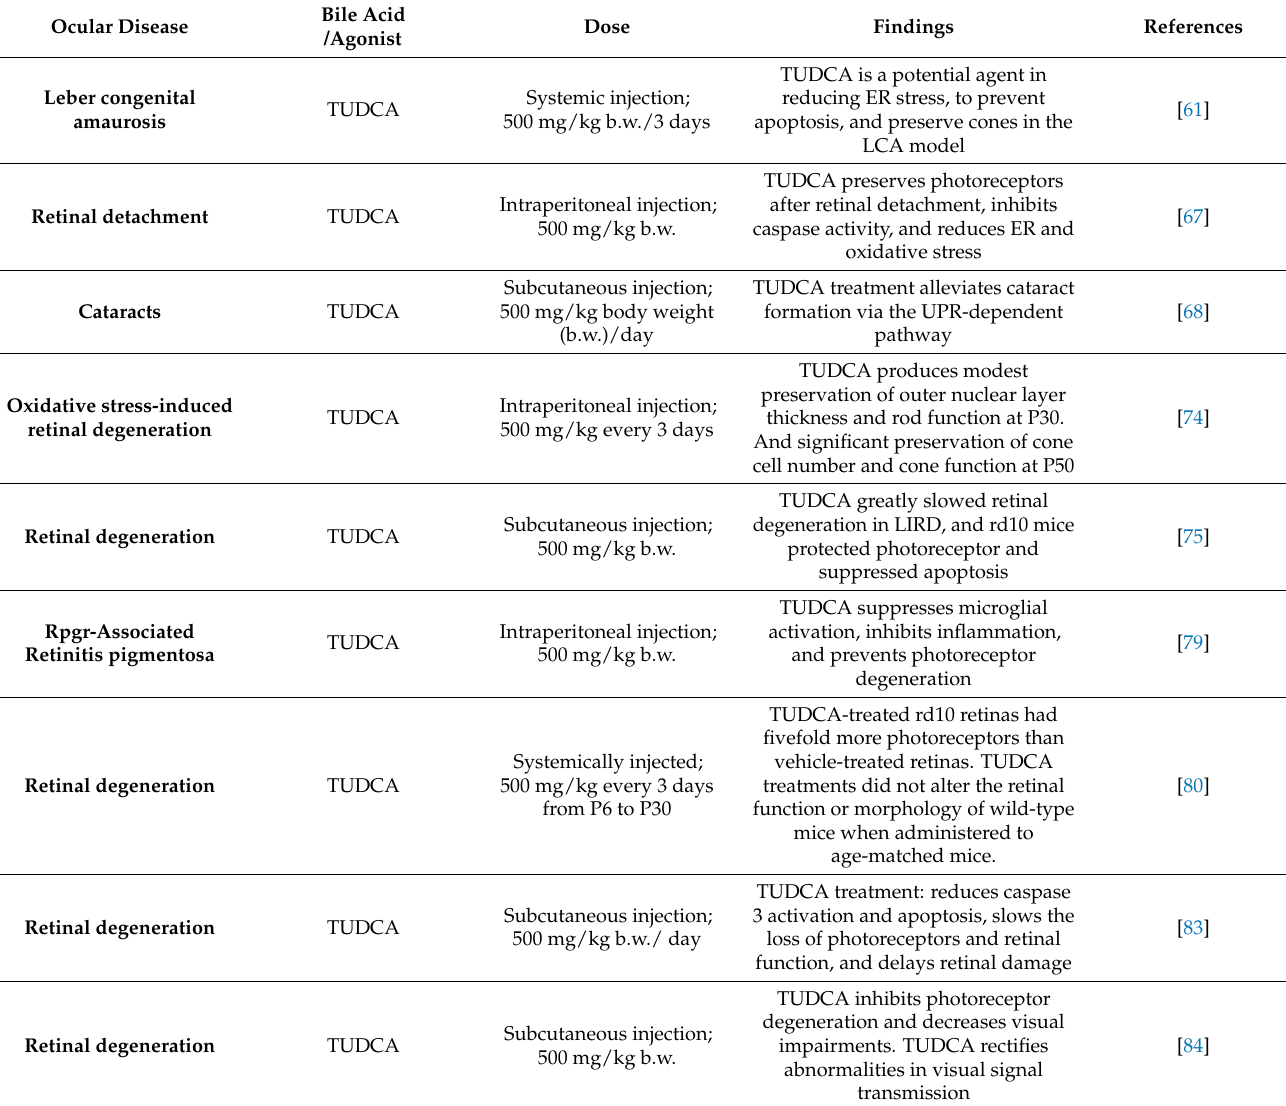
Table 2. Pharmacological effects of bile acid treatments on various ocular diseases. Ocular